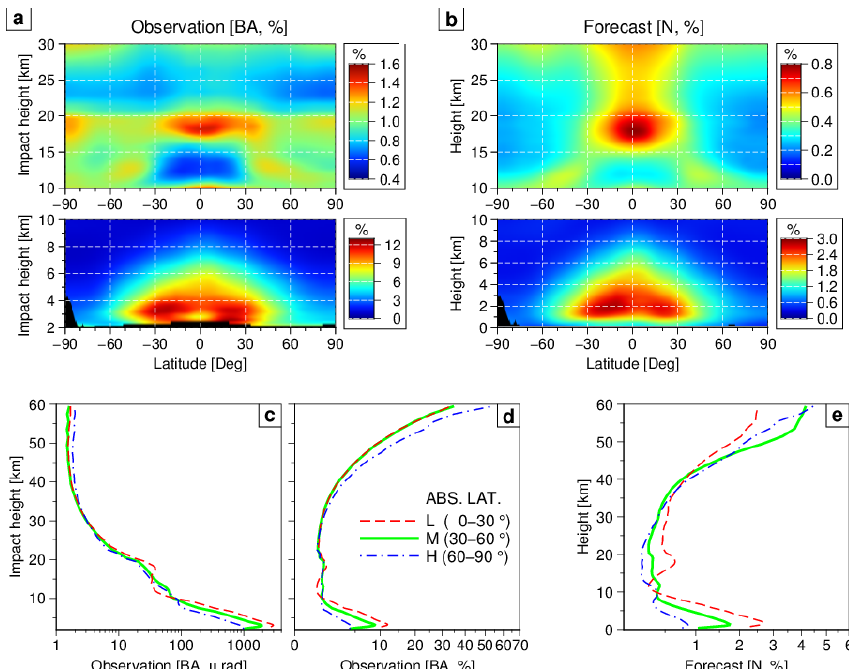
Figure 1. An example of diagonal elements of (a) R and (b) B diagnosed with HL. Shown are the error standard deviations (%) of (a) observed bending angle and (b) forecast refractivity, averaged along the longitude and over the whole data period. The bending angle σ o averaged in three latitude bands (low latitude, red dashed; middle latitude, solid green; high latitude, blue dashed dot) is shown in the unit of (c) 10 − 6 rad and (d) %. Panel (e) is the same as in panel (d) except for refractivity σ f